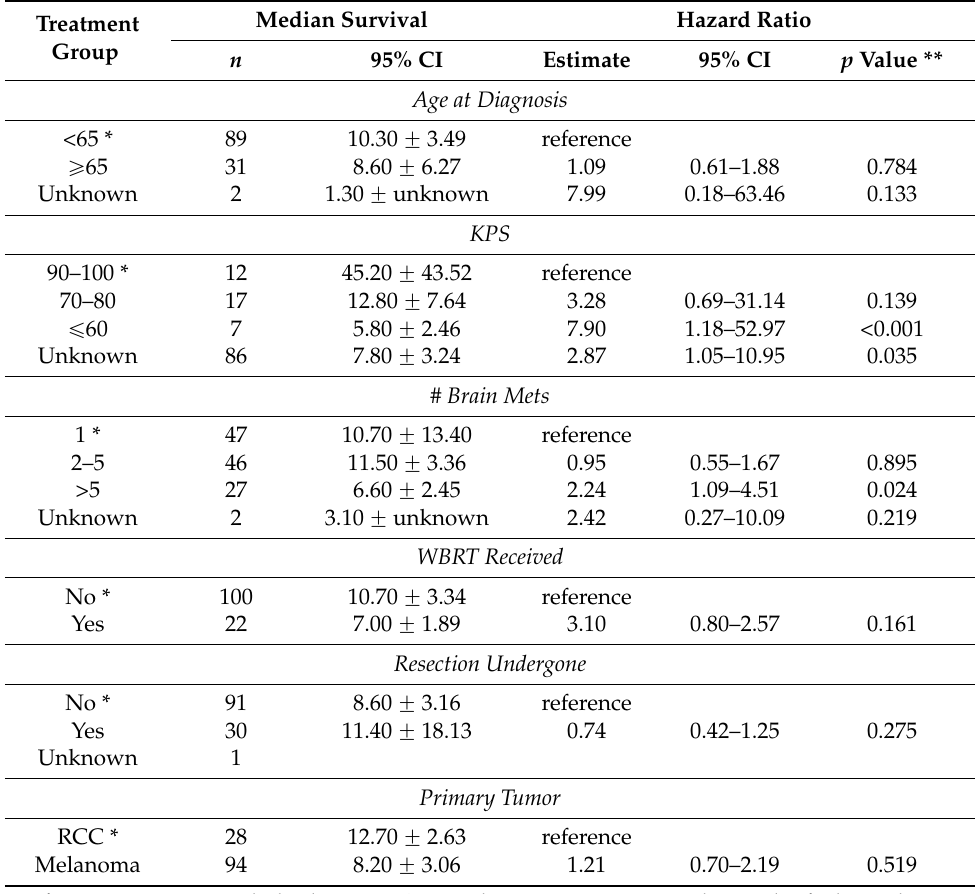
Table 2. Univariate median survival estimates (months) and hazard ratios.